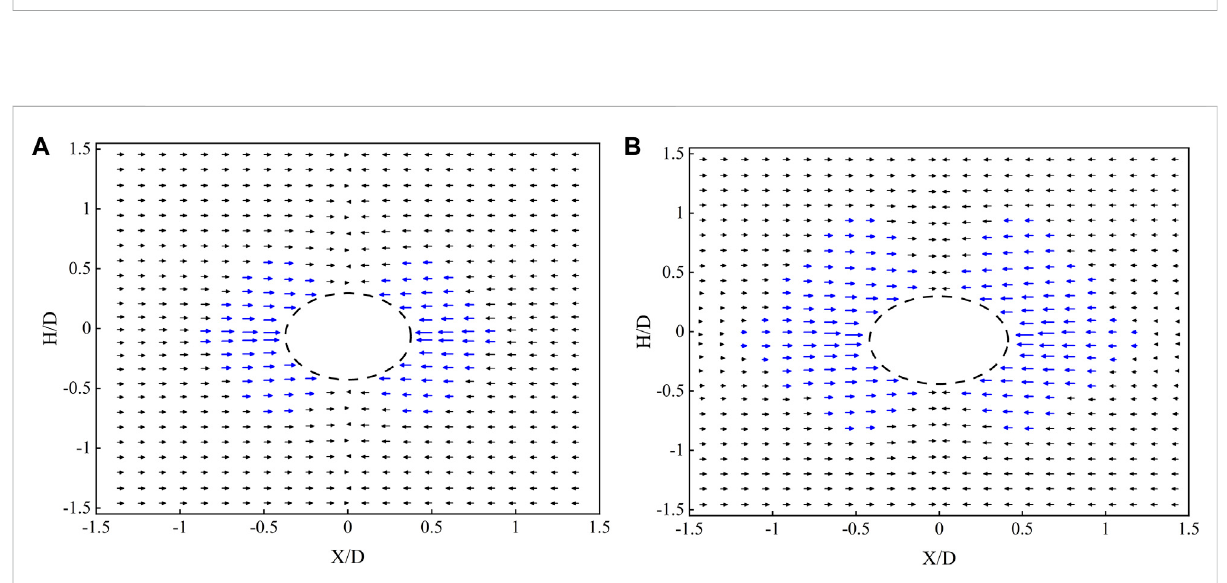
Figure 10. The main in fl uence range of displacement and settlement of excavation face 1 and excavation face 2